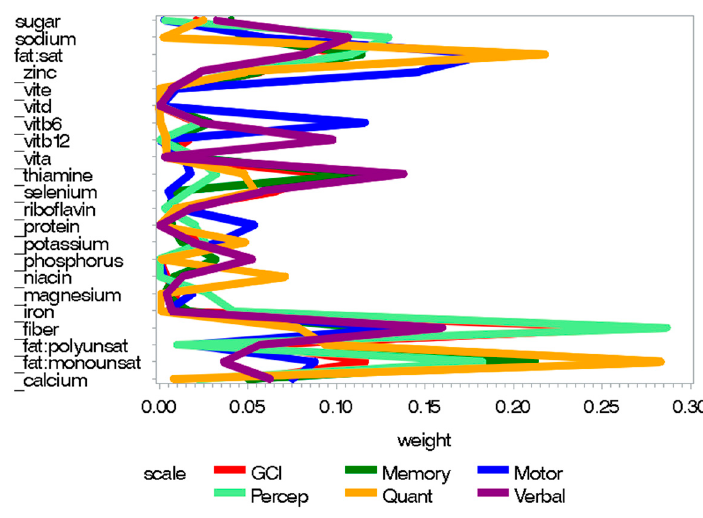
Figure 2. Weight plots for statistically significant scales from the prenatal “poor nutrition” index, including dietary and supplemental nutrition intake.